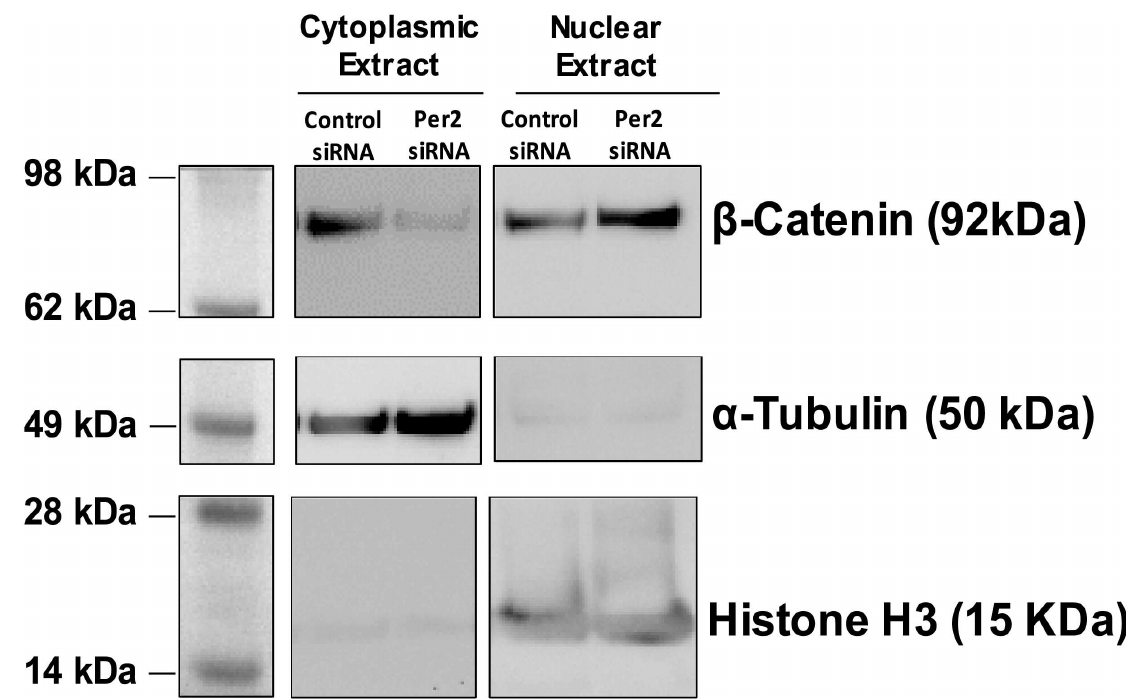
Fig 5. Nuclear entry of β -catenin after treatment of HRECs with siRNA Per2 . Per2 or control siRNA-treated HRECs were processed to separate nuclear and cytoplasmic fractions. Representative western blots showed nuclear translocation of β - catenin after treatment with Per2 siRNA. Histone H3 and α -tubulin were used as loadingcontrols for nuclear and cytoplasmic fractions, respectively n =